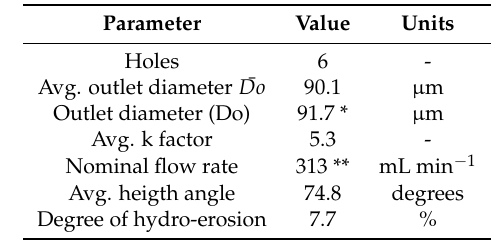
Table 1. Injector